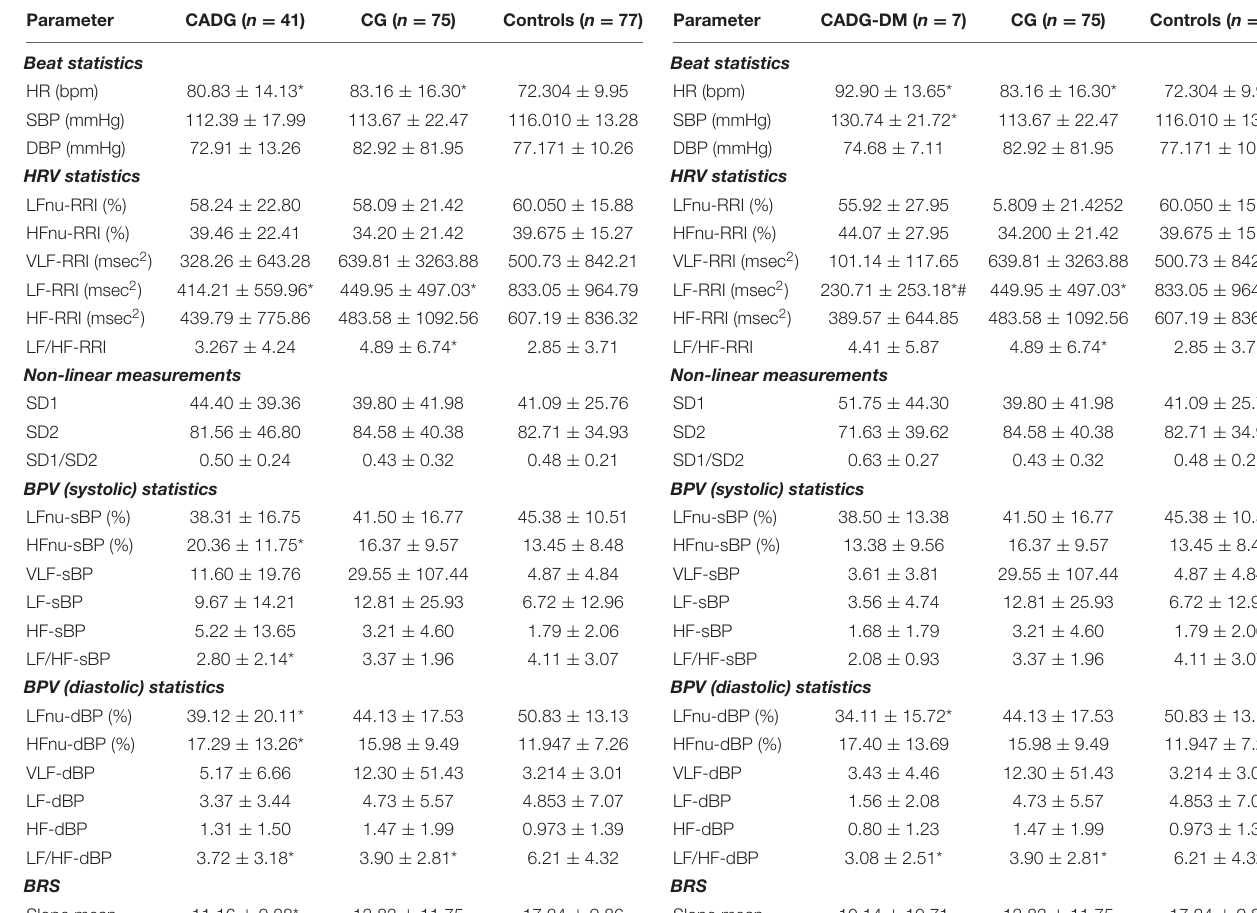
TABLE 7 | HRV and BPV in COVID-19 group with diabetes mellitus